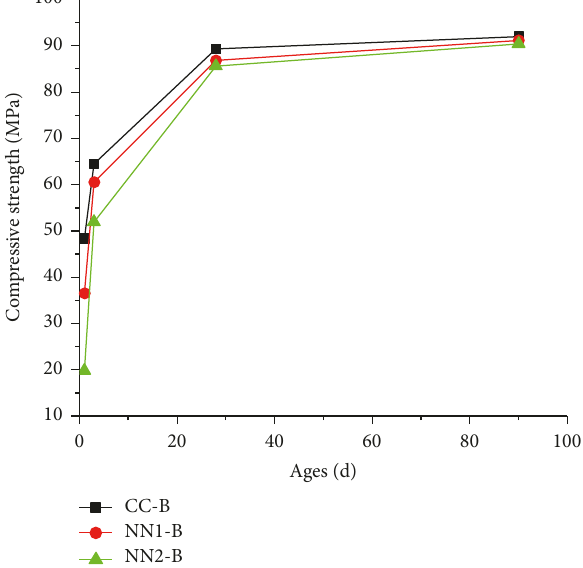
Figure 17: Compressive strength of the standard-cured concrete with W/B of